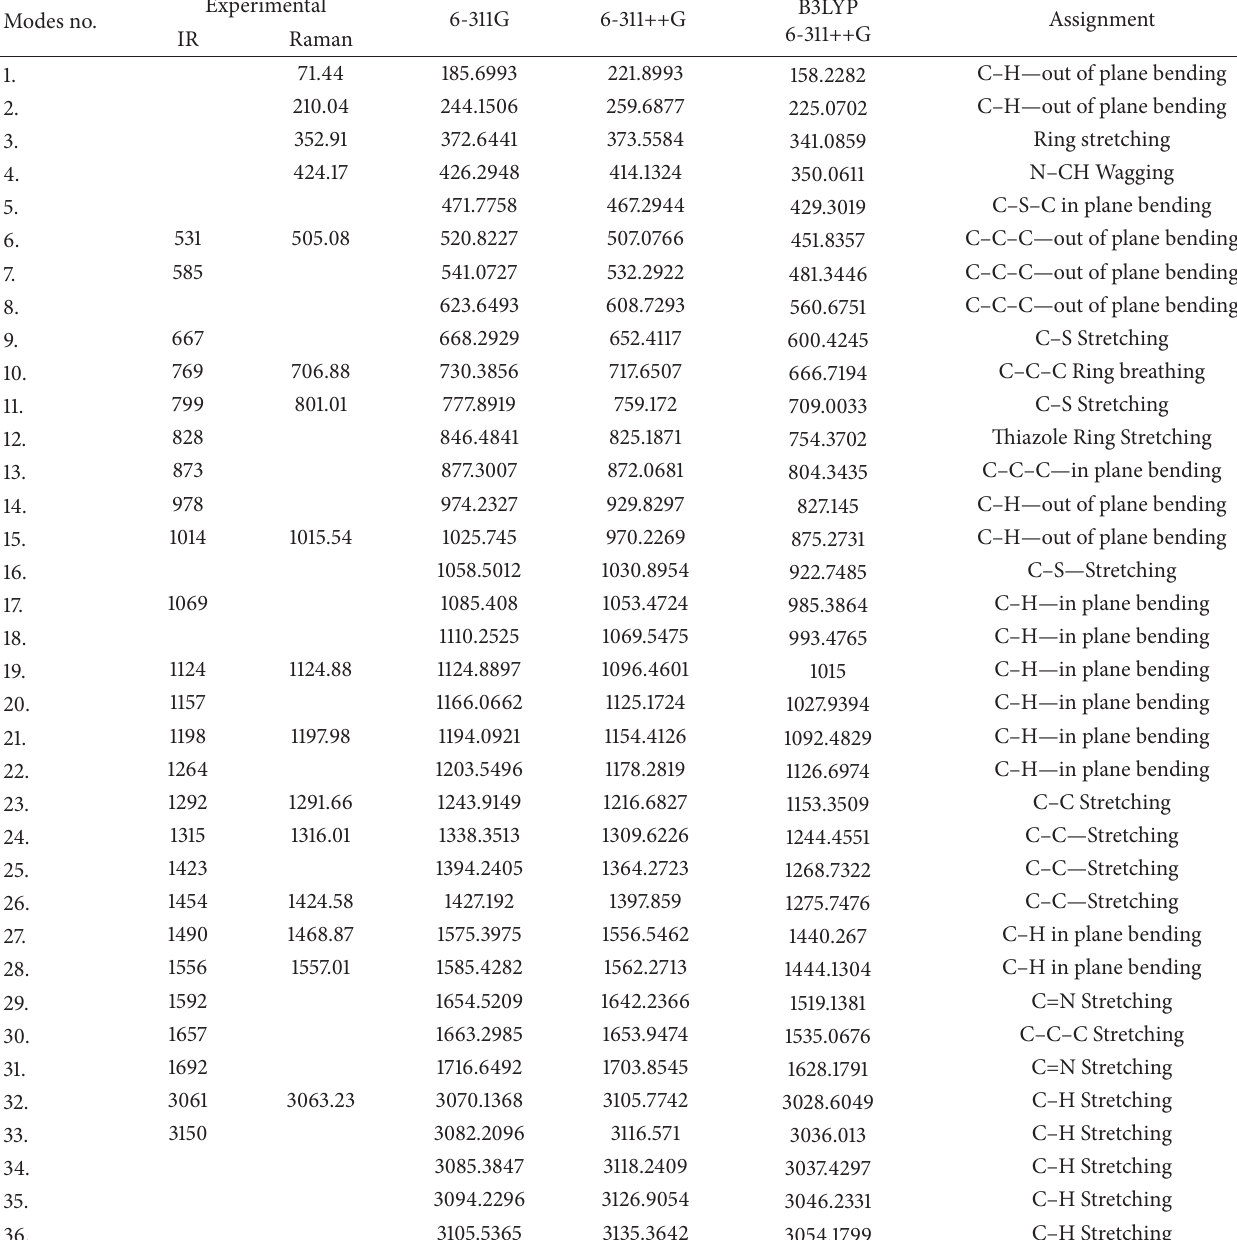
Table2:Comparisonoftheexperimental(FT-IRandFT-Raman)andtheoreticalharmonicwavenumbers(cm − 1 )of benzothiazolecalculated by HF, B3LYP with 6-311++G(d, p) basis